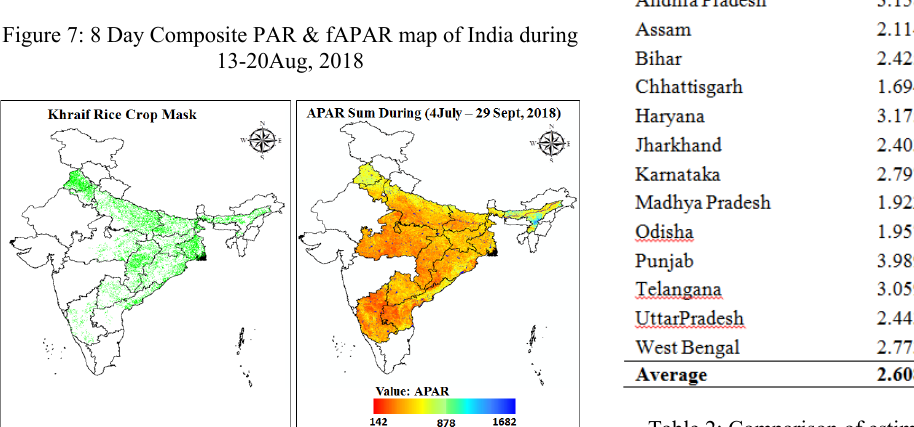
Table 2: Comparison of estimated yield with reported DES